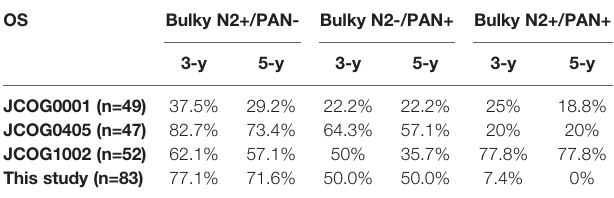
TABLE 3 | Overall survival rates for different patients in four studies.